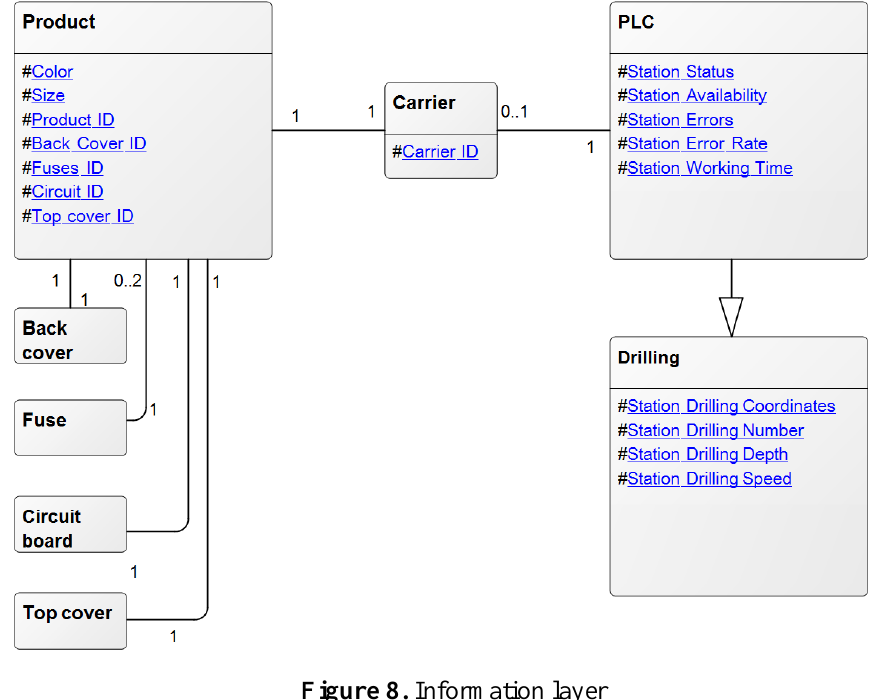
Figure 8. Information layer